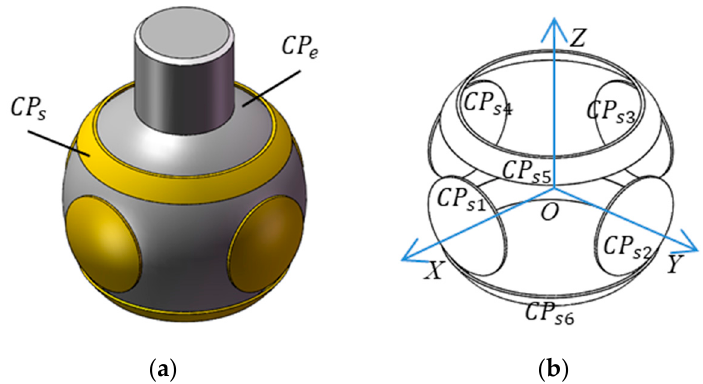
Figure 1. Structural model of the proposed capacitive sensor ( a ) structural assembly ( b ) distribution of the capacitive plates.